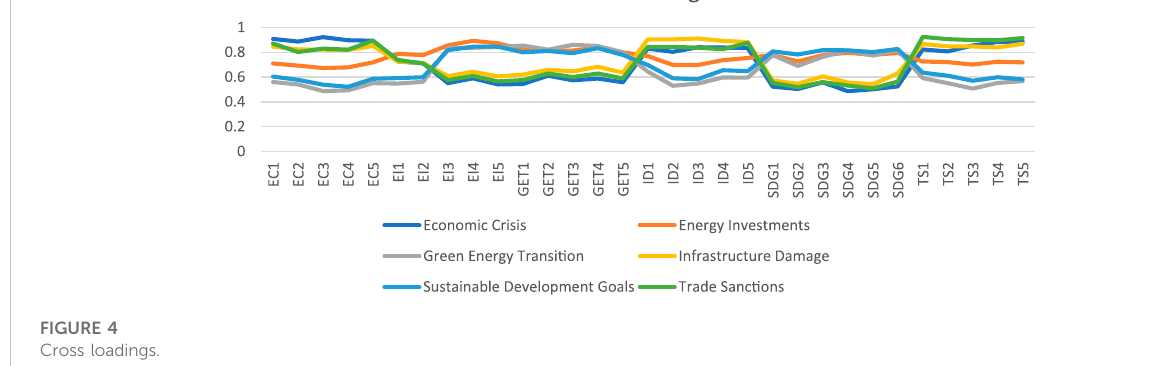
FIGURE 4 Cross loadings.